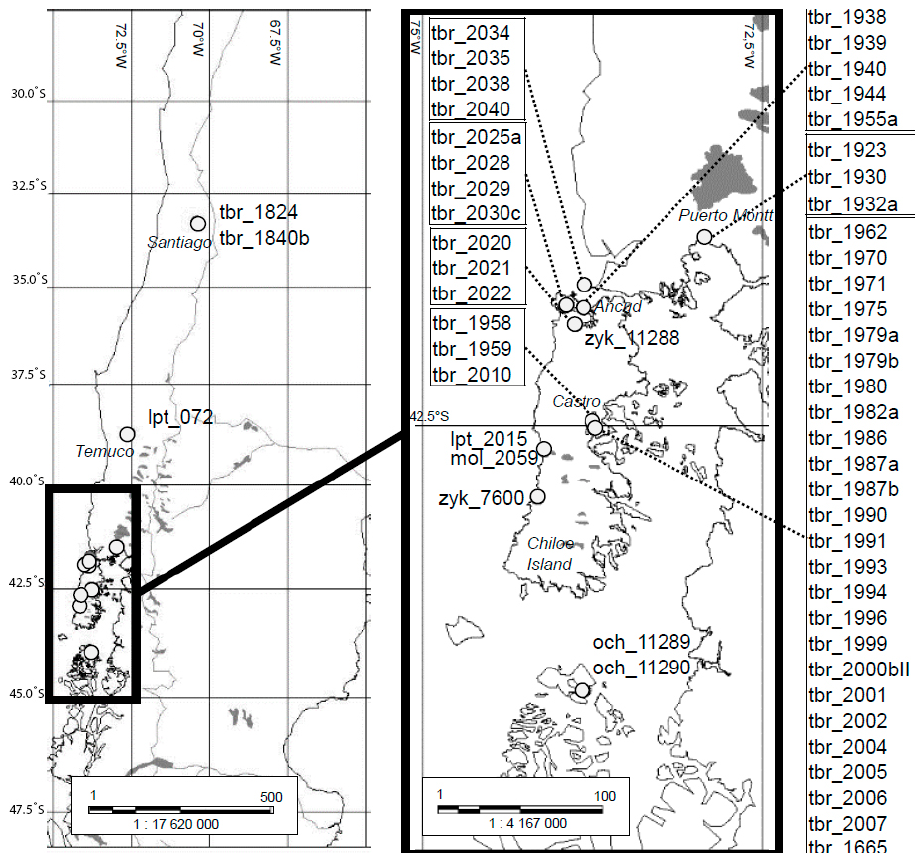
Figure 1. Map showing the collection sites of Chilean samples from the herbarium subset. Tbr, S. tuberosum subsp. tuberosum ( S. tuberosum ‘Chilotanum group’; lpt, S. leptostigma ; mol, S. molinae